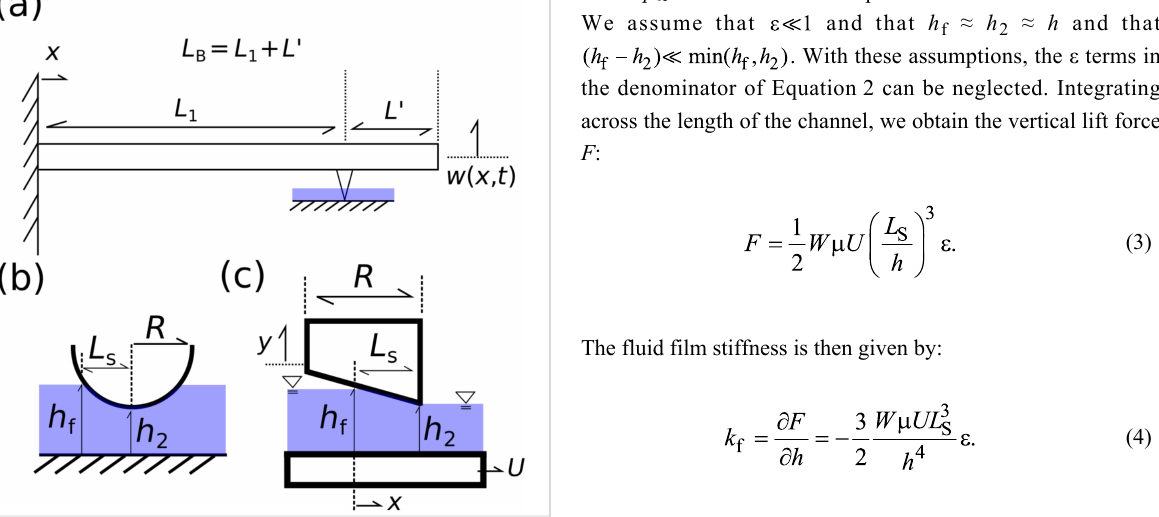
Figure 2: (a) Schematic of the CR system under analysis. The total length of the beam L B = L 1 + L ′ is comprised of the distance from the fixed end of the beam to the tip position given by L 1 , and the distance from the tip position to the free end of the beam given by L ′ . (b) Spheri- cal AFM tip submerged in fluid of height h f and a distance h 2 from the sample surface. (c) Approximated tip geometry. Stationary inclined slider of length L S . The sample surface moves at a uniform speed U = V S